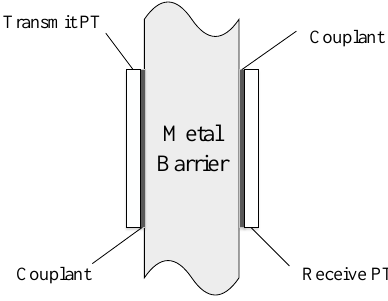
Figure 1. Typical acoustic-electric